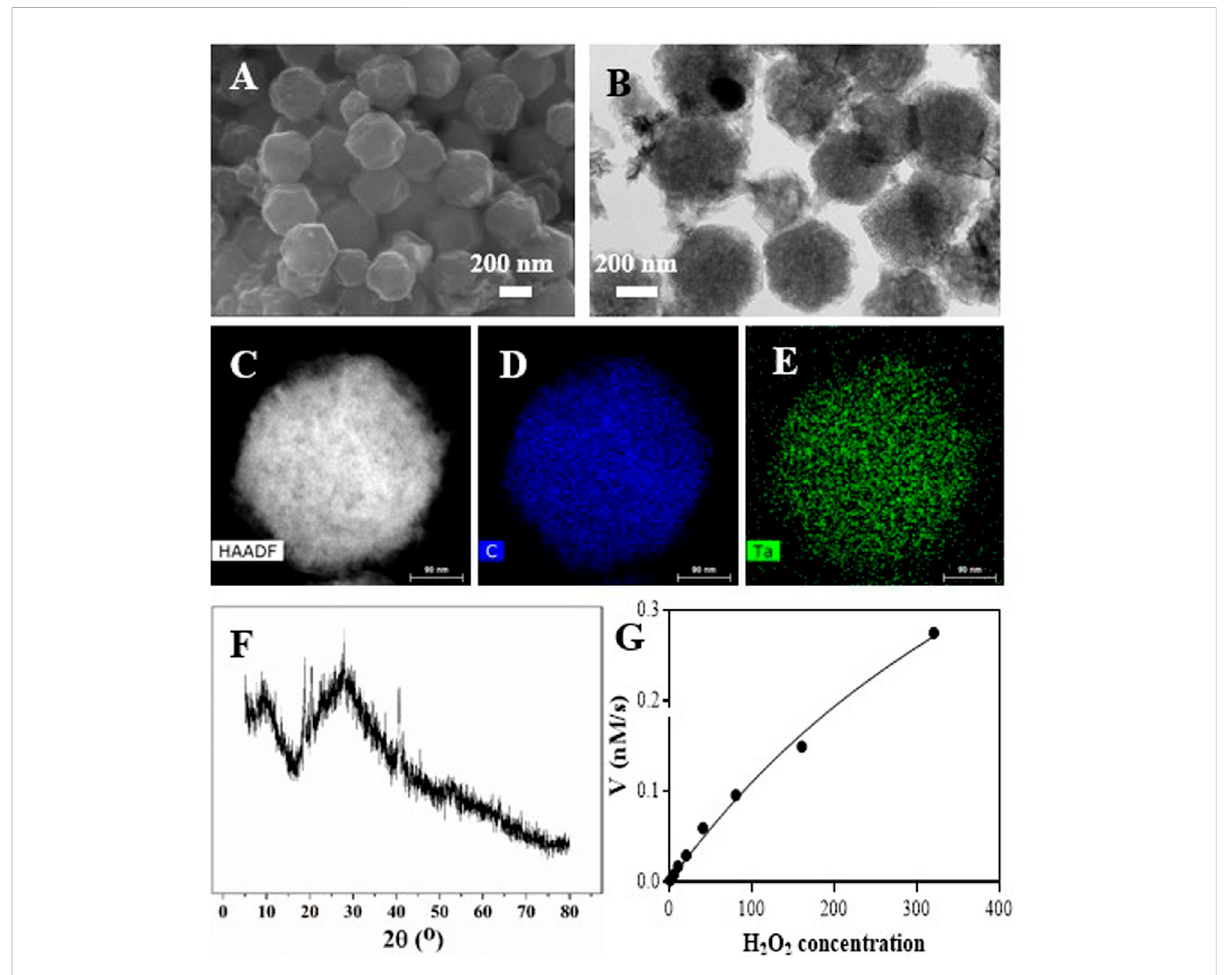
Characterization of the Ta-PMCS. (A) SEM image of the Ta-PMCS; (B) TEM image of the Ta-PMCS; (C) HAADF image of Ta-PMCS; (D,E) Elemental mapping images of C, and Ta. (F) PXRD of Ta-PMCS; (G) catalase-like activity of